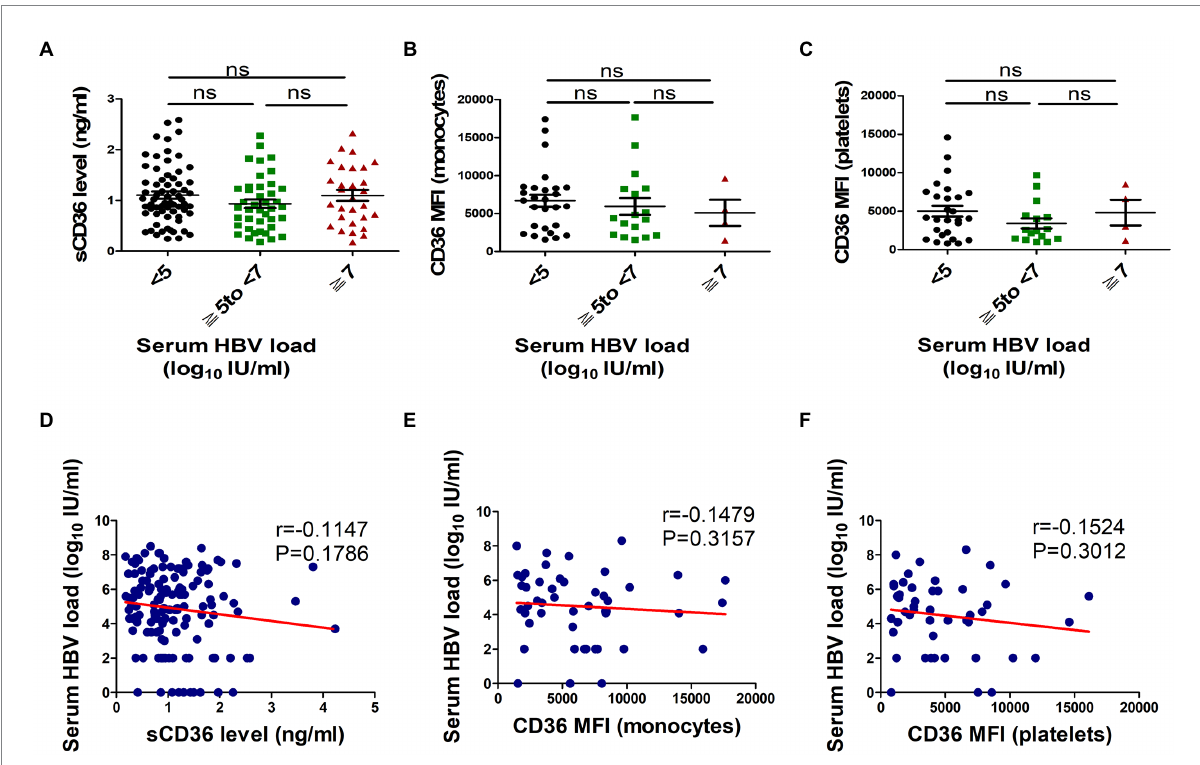
FIGURE 3 Correlations analysis of plasma sCD36 levels with HBV DNA in HBV-infected patients. Plasma sCD36 level (A) , monocyte CD36 expression (B) and platelet CD36 expression (C) with different viral load (< 5, ≥ 5–7 and ≥ 7 log10 IU/mL); d-f Correlation analysis between HBV DNA levels with plasma sCD36 (D) , monocyte CD36 expression (E) and platelet CD36 expression (F) . The differences between two groups were analyzed by Man - Whitney U test. Correlation analysis were calculated using the Spearman’s rank correlation for non-parametric data. ns, no statistical